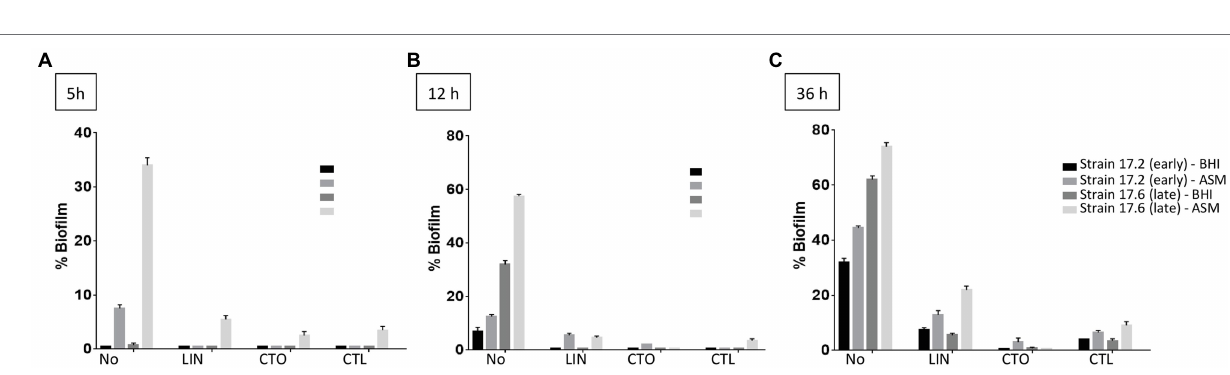
FIGURE 5 | Dynamics of biofilm formation (% of biofilm formed) in BHI medium and ASM in the presence of antibiotics for two strains isolated 3 years apart in Patient 17 (strain 17.2: “early” strain and 17.6: “late” strain). Results are presented comparatively to those observed in the absence of antibiotic previously presented in Figure 4 . (A) After 5 h of incubation; (B) after 12 h of incubation; (C) after 36 h of incubation. No, no antibiotic; LIN, linezolid; CTO, ceftobiprole; and CTL, ceftaroline. Antibiotics were added to a final concentration equivalent to the minimum biofilm inhibitory concentration (bMIC) in the corresponding medium as follows: strain 17.2, bMICs in BHI medium and in ASM: CTL: 0.125 mg/L, CTO: 0.25 mg/L, LIN: 0.5 mg/L; strain 17.6, bMICs in BHI medium: CTL: 0.25 mg/L, CTO: 0.5 mg/L, LIN: 2 mg/L; bMICs in ASM: CTL: 4 mg/L, CTO: 4 mg/L, and LIN: 2 mg/L. Data are commented for statistical significance in the